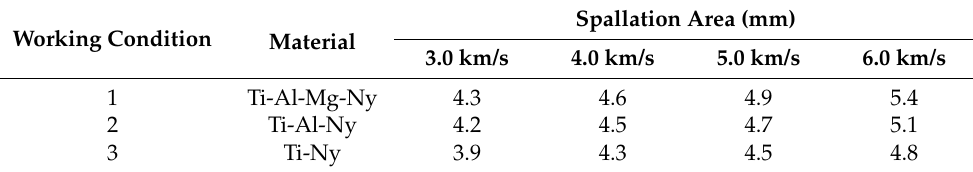
Figure 10. Calculation results of one-dimensional strain collision of aluminum alloy material ( left ) and Al/Mg gradient material ( right ). Table 7. Calculation results of one-dimensional strain-collision-spalling region of aluminum alloy materials and Al/Mg gradient materials.